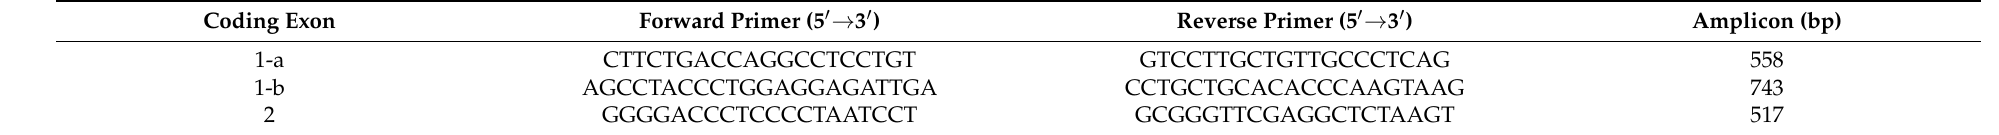
Table 2. Primers to amplify the coding exons and splice donors/acceptors of the KLF15